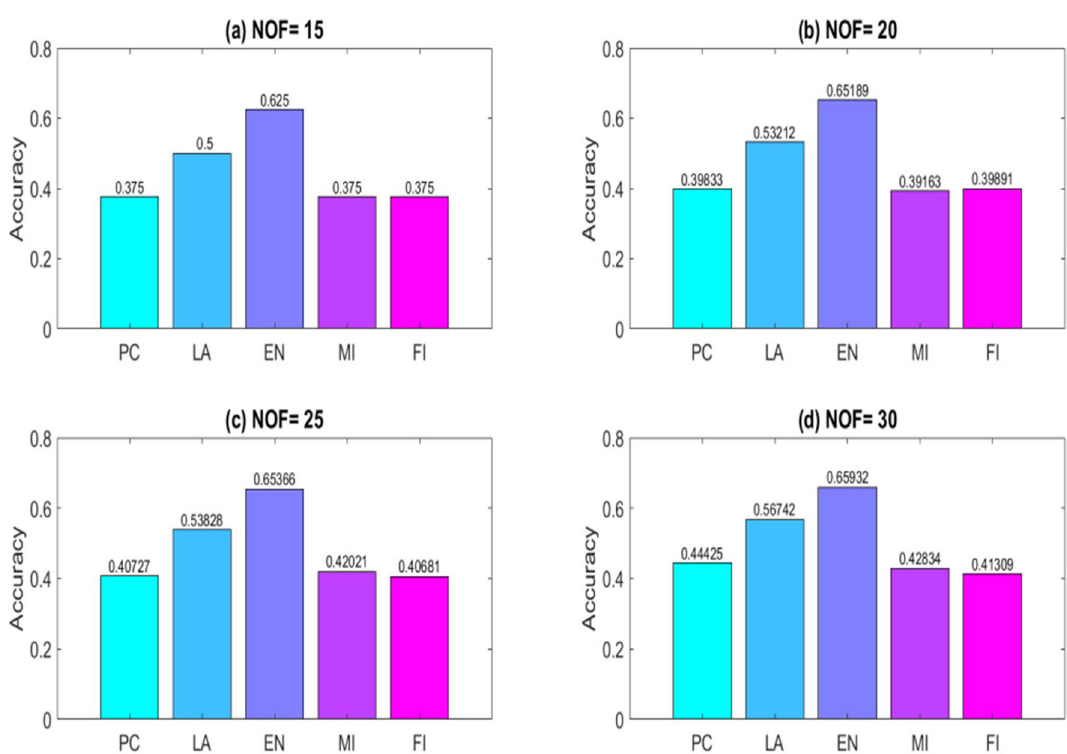
Figure 17. Outcomes of the filter FS methods on the Lung dataset with selecting ( a ) 15, ( b ) 20, ( c ) 25, and ( d ) 30 features. The EN method with an average of 81% accuracy is better than other approaches. PC, Pearson correlation; LA, Laplacian score; EN, entropy; MI, mutual information; FI, Fisher